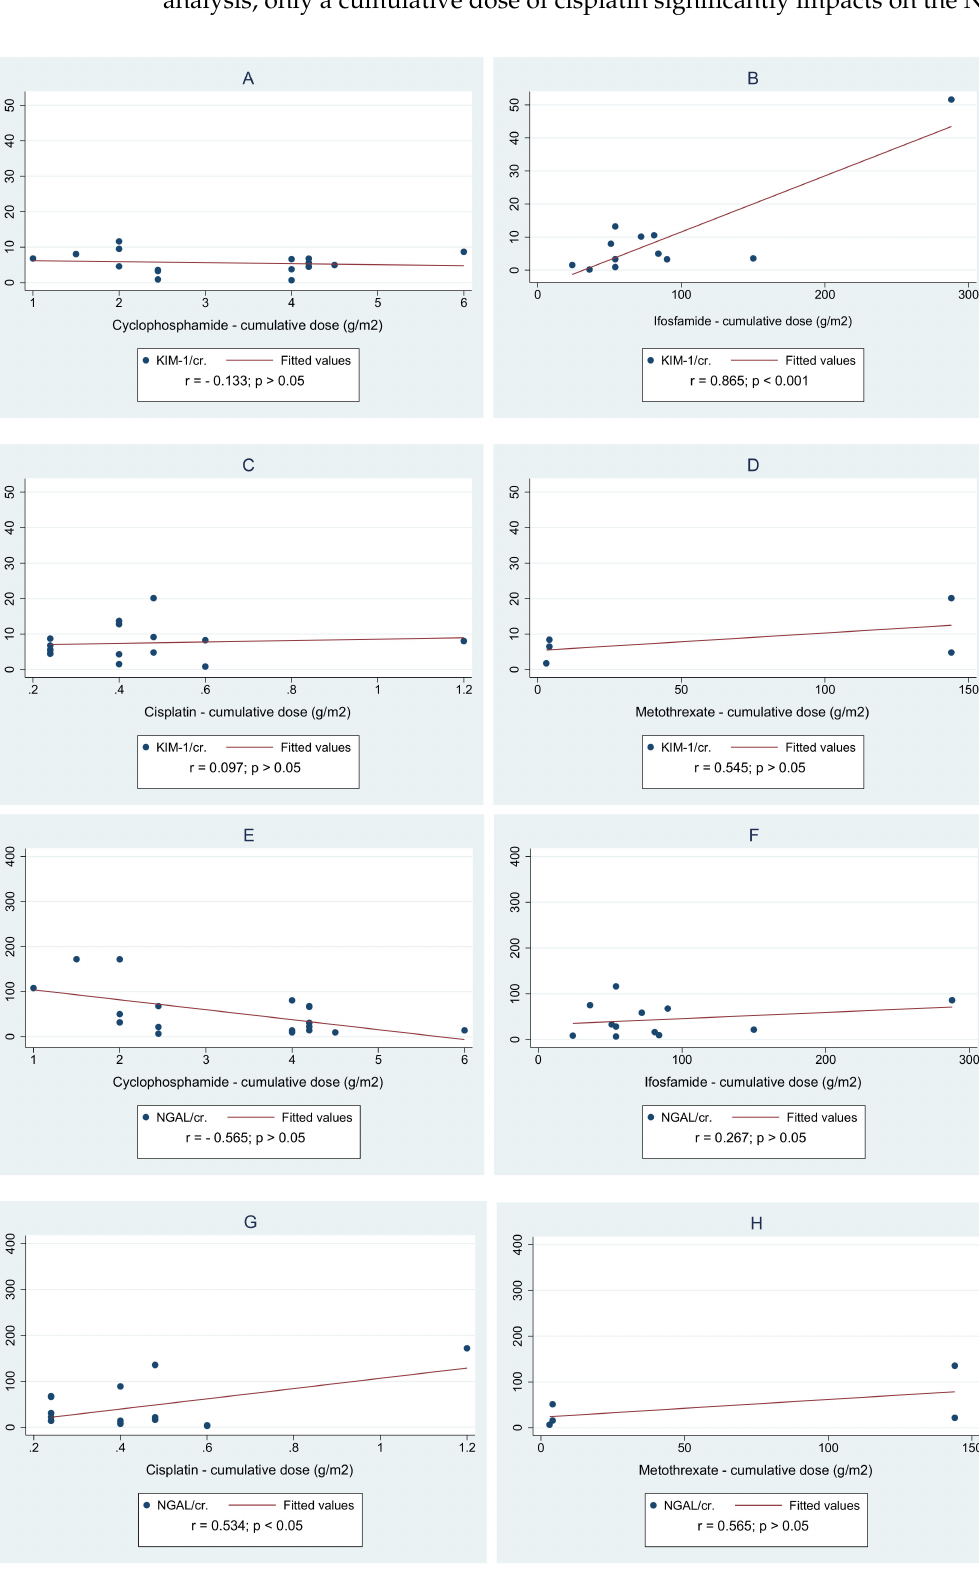
Figure 3. Spearman correlations of urine biomarkers ratios: KIM-1/cr. ( A – D ) and NGAL/cr.( E – H ) and cumulative dose of cytostatics used during chemotherapy in